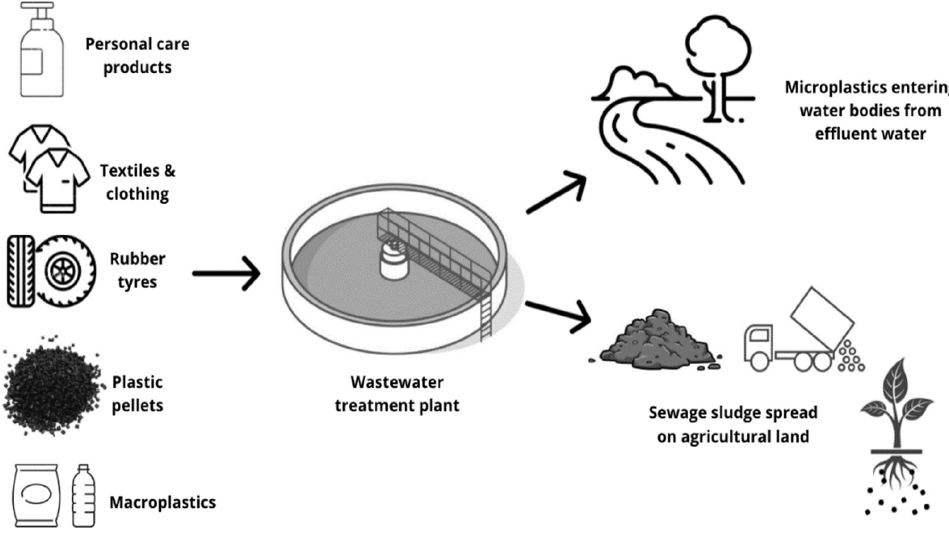
Figure 1. Environmental risks associated with sewage sludge reuse.